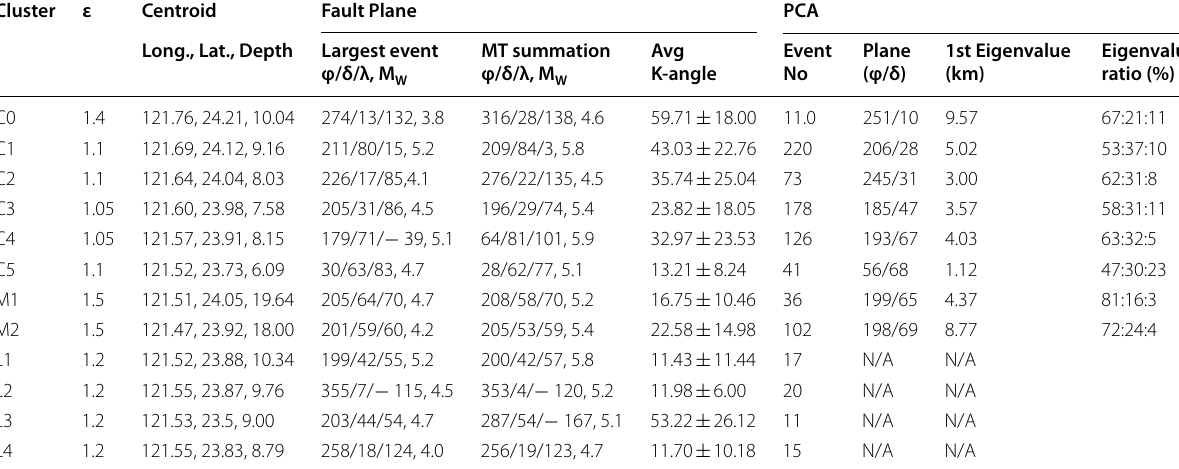
Table 2 DBSCAN and PCA results of 2018–2021 Hualien earthquake sequence Cluster Centroid Fault Plane